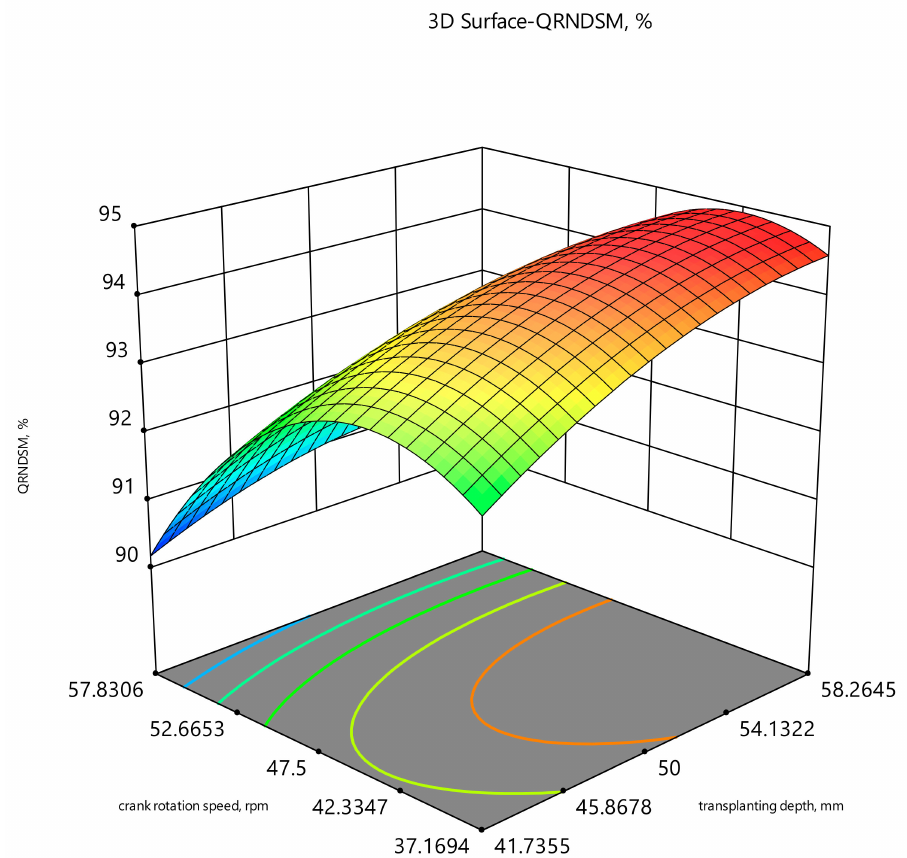
Figure 13. The interaction of transplanting depth and crank rotation speed on